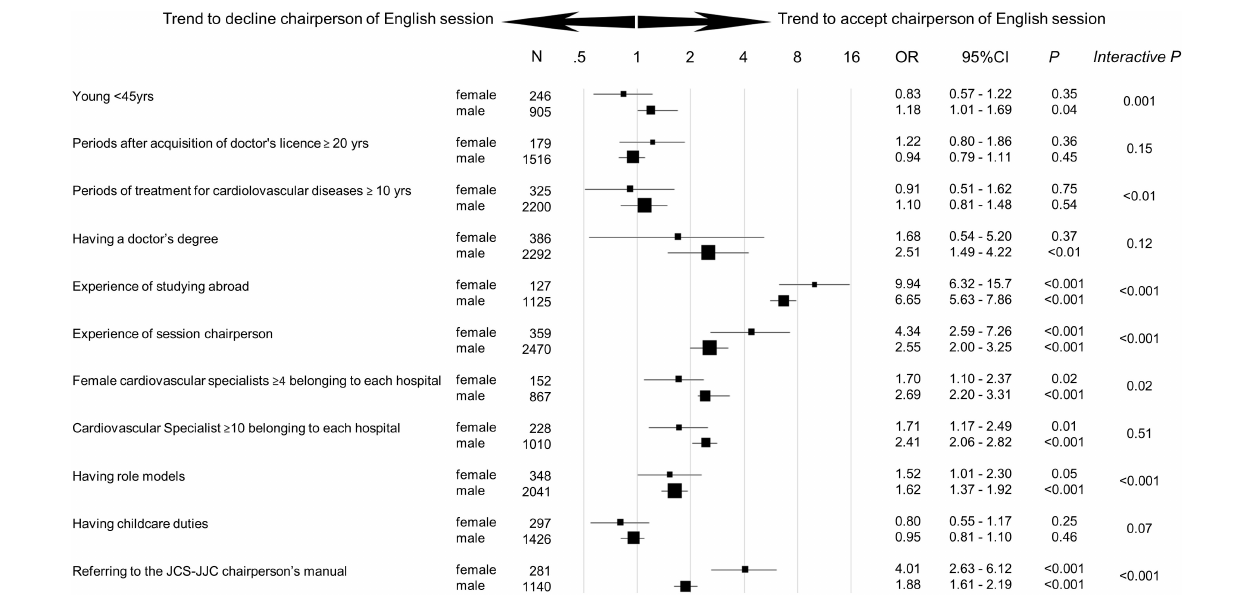
FIGURE 5 | Trend to accept chairperson of English session by gender. Odds ratio [95% confidence interval ( CI) ] for the trend to accept the chairperson of the English session by gender was analyzed in each subgroup. Interactive P was used as an index to measure the strength of each factor within male vs. female group. Ph.D., Doctor of Philosophy.